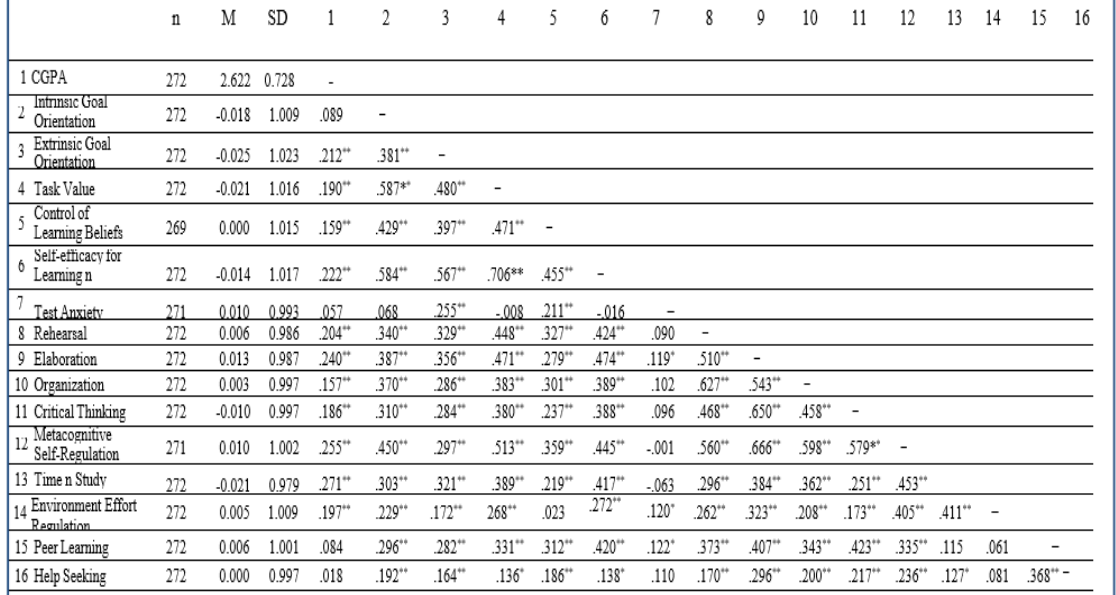
Figure.1: Path diagram with weights, covariance, and correlations